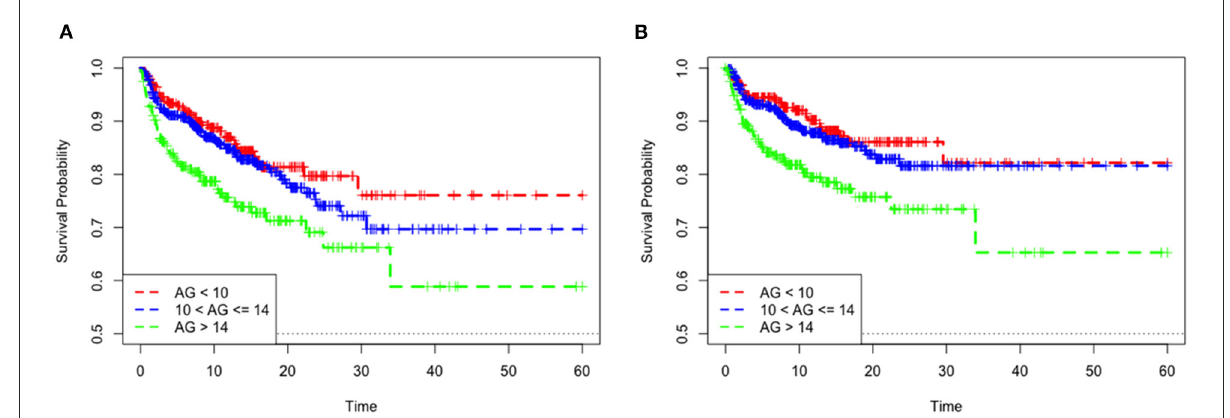
FIGURE3 Kaplan–Meier survival curve of mortality among quartile groups of serum anion gap. In-hospital mortality (A) . ICU mortality (B) .